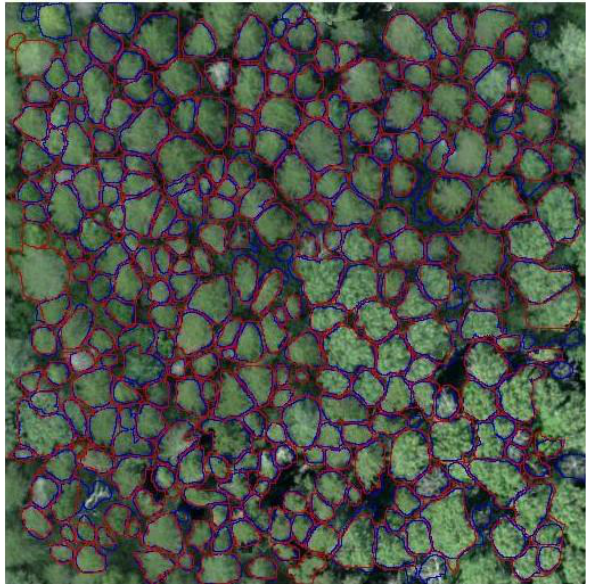
Figure 9 . ITC delineation result (blue circle) generated by attention U-net, together with the tree crowns manually labelled (red circles) for the test size #1.